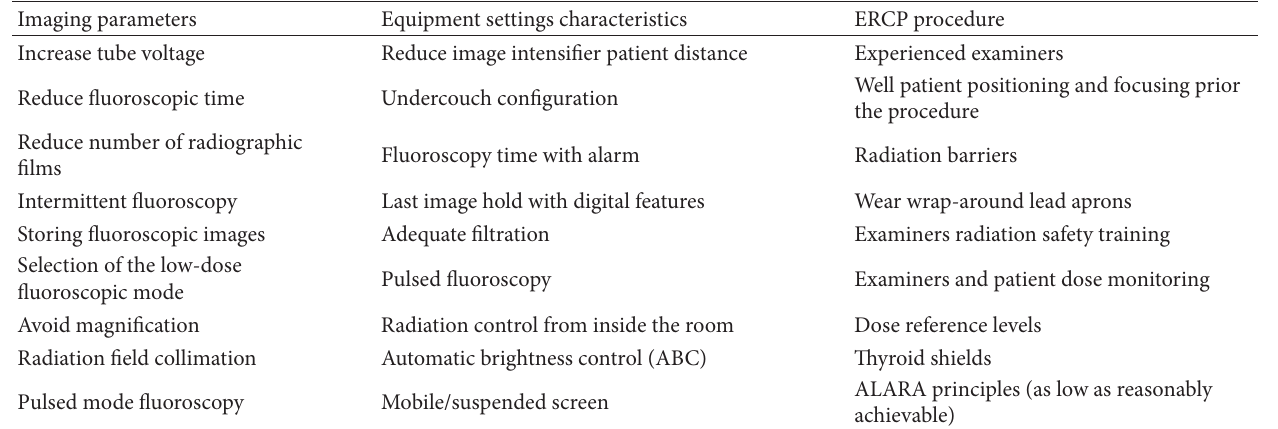
Table 8: Patients dose reduction techniques during